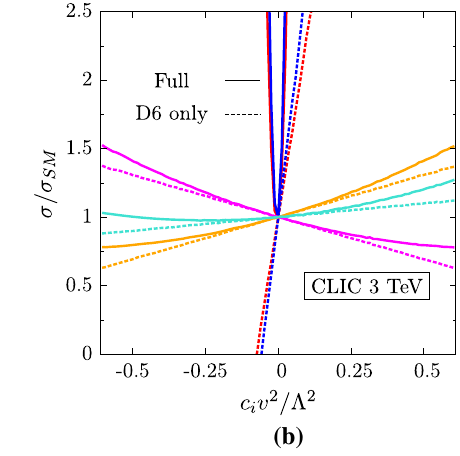
= p t − p ¯ t spectrum. All distributions T T T